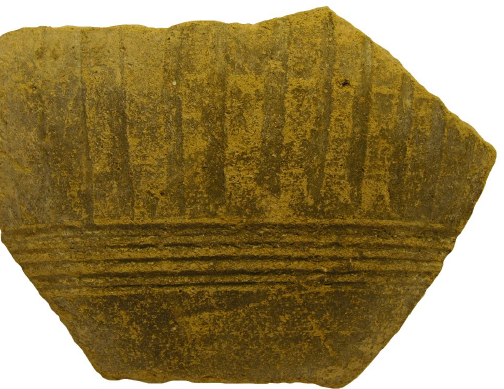
Figure 15. Black Slip I–II jug fragment from the sanctuary at Agia Irini, AIS 0804.034, H. 6.4 cm, ©